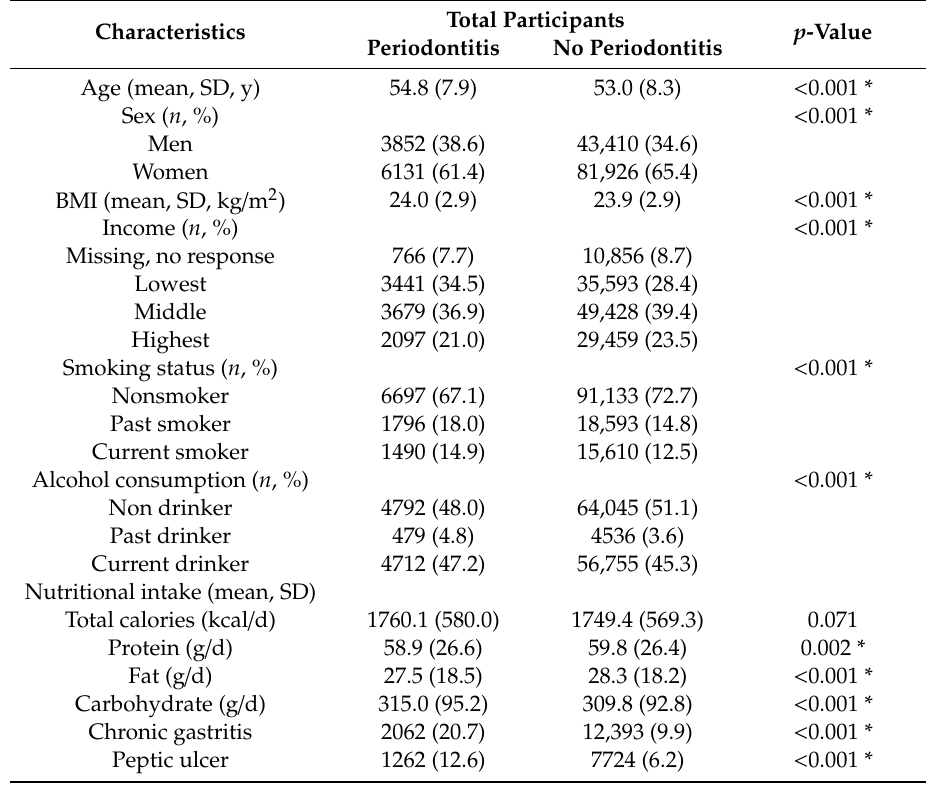
Table 1. General characteristics of